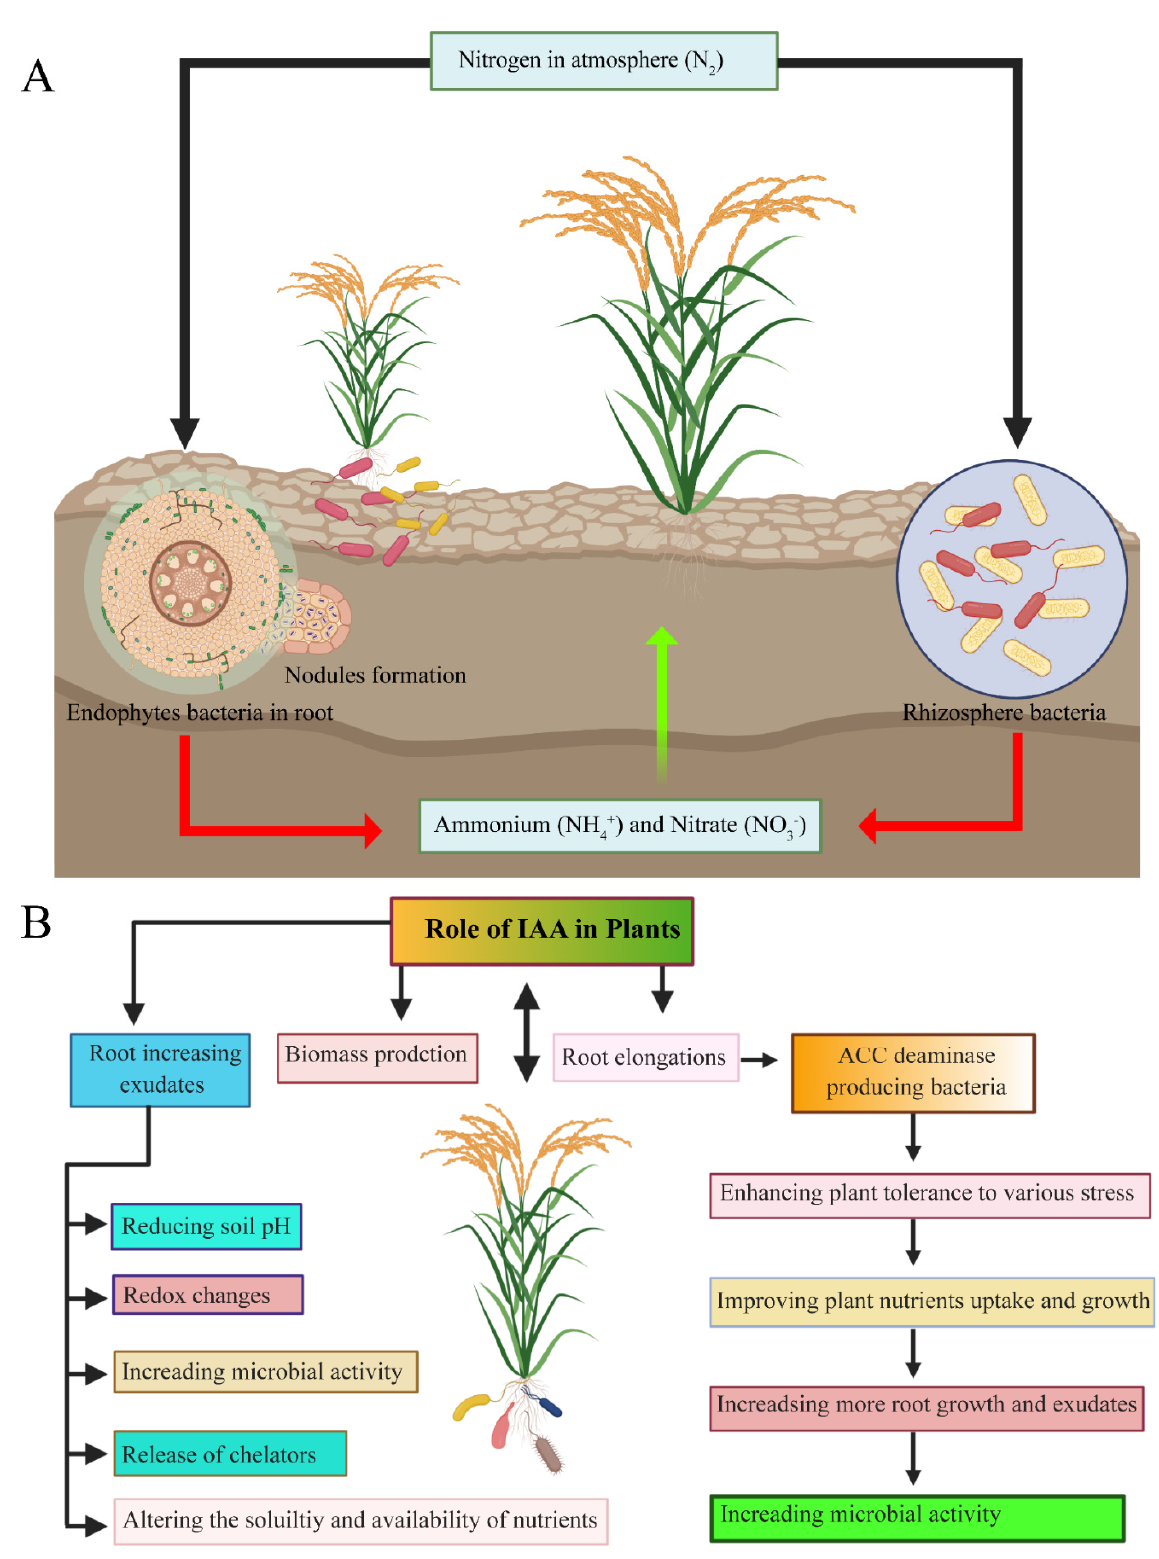
Figure 4. Direct plant-growth promotion by endophytic bacteria. ( A ) Process of biological nitrogen fixation from the atmosphere by beneficial bacteria. ( B ) Importance of Indole-acetic-acid (IAA) for plant growth. Figure was created by Bio ‐ Render.